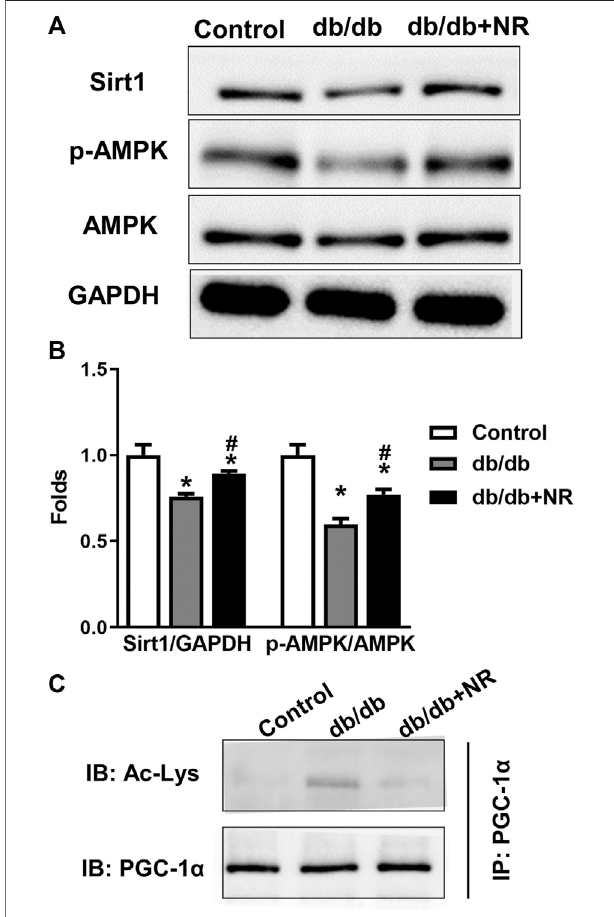
FIGURE4| EffectofNRsupplementontheexpressionofSirt1/AMPKin BM-EPCs. (A) Western blot of Sirt1/AMPK in BM-EPCs isolated from normal control and diabetic mice. (B) Quantitative analysis of Sirt1 and p-AMPK expression taken as in (A) . (C) The level of acetylated PGC-1 α was measured.Valuesaremean ± SEM,( n (cid:2) 3).* P < 0.05 vs. Control; # P < 0.05 vs. db/db